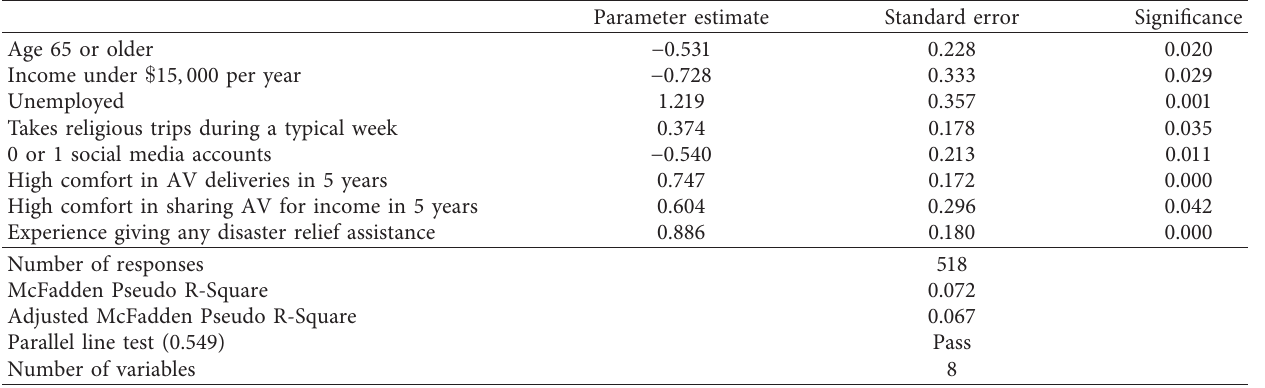
Table 2: Ordinal logit regression model.